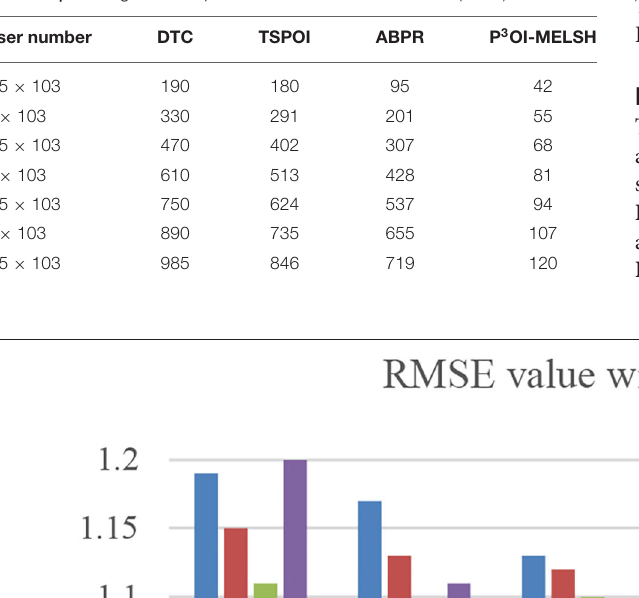
TABLE 2 | Running time comparison with different film number (unit/s).